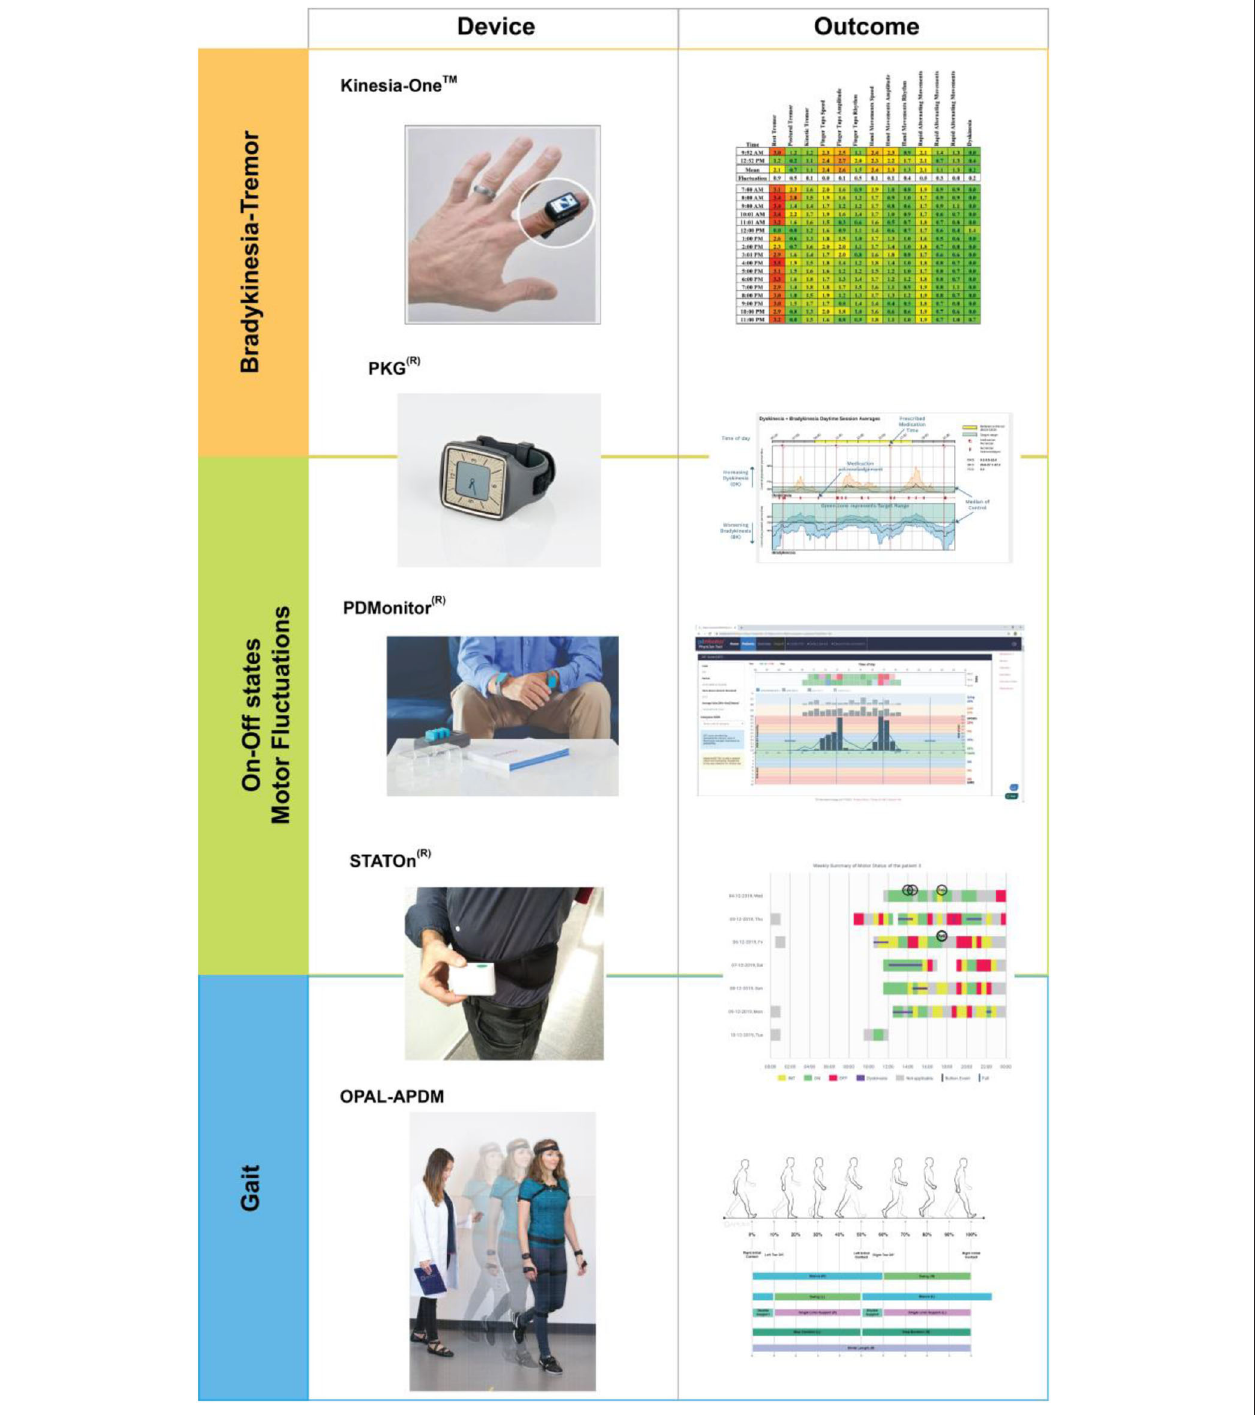
FIGURE 2 | Inertial measurement unit devices approved for used in movement disorders. Relevant examples of different devices and the generated information are presented according to their main application (i.e., the Kinesia system can also be used for dyskinesia and gait, see Table 1 ). The different results obtained with the use of each of the devices are presented. Images provided by Kinesia TM , Great Lakes NeuroTechnologies; PKG ® , Global Kinetics Corporation; PDMonitor ® , PD Neurotechnology ® Medical Solutions; STAT-ON, Sense4Care; Opal, APDM Wearable Technologies. Adapted from Monje MHG and Sánchez-Ferro A. Sistemas inerciales y análisis del movimiento. In: Manual de Nuevas Tecnologías en Trastornos de Movimiento, 2020 (in press) .